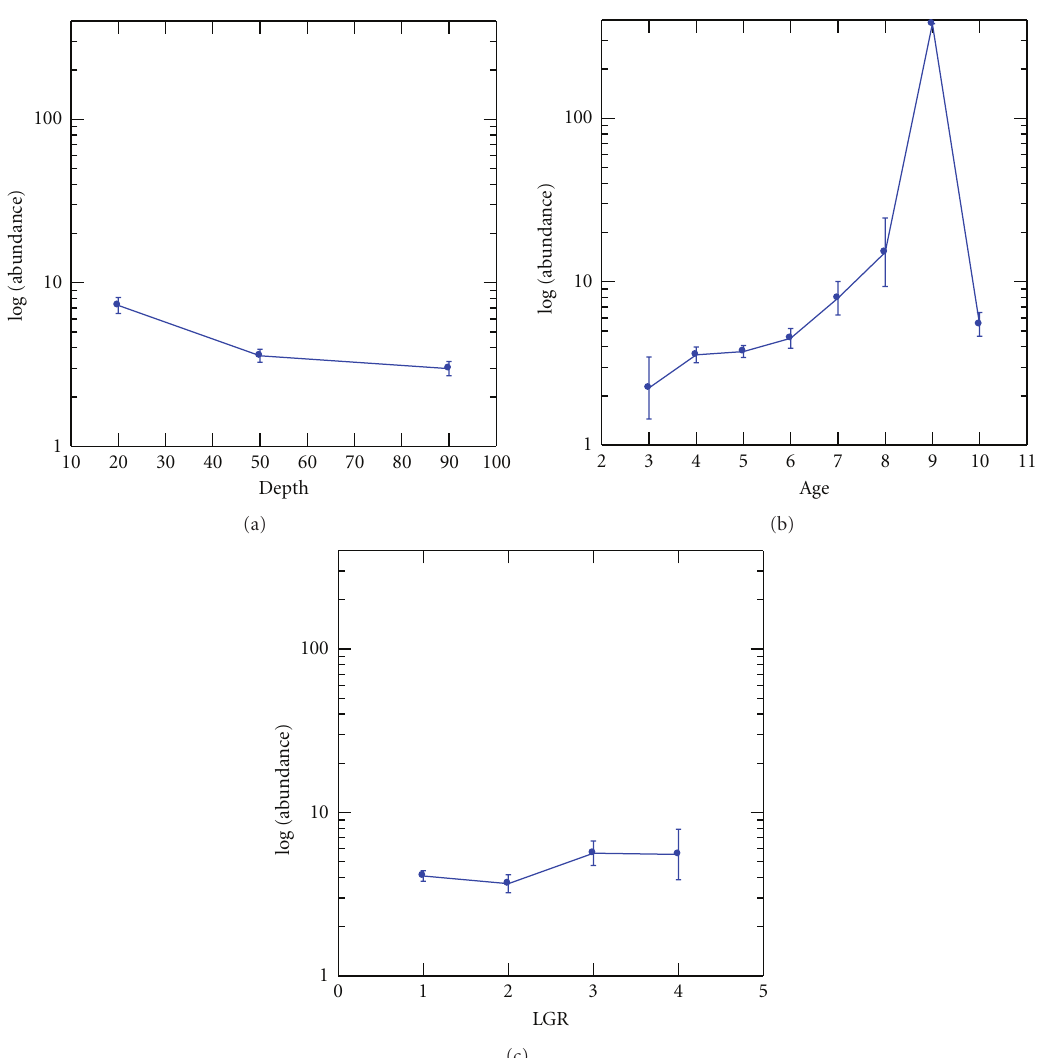
Figure 3: Abundance (logarithmic scale), of sealworm larvae ( Pseudoterranova sp. (p)) in cod ( Gadus morhua ) in relation to length-groups of fish ((1) 40–54 cm, (2) 55–59 cm, (3) 60–69 cm and (4) > 70cm), fish-age, and sea-water